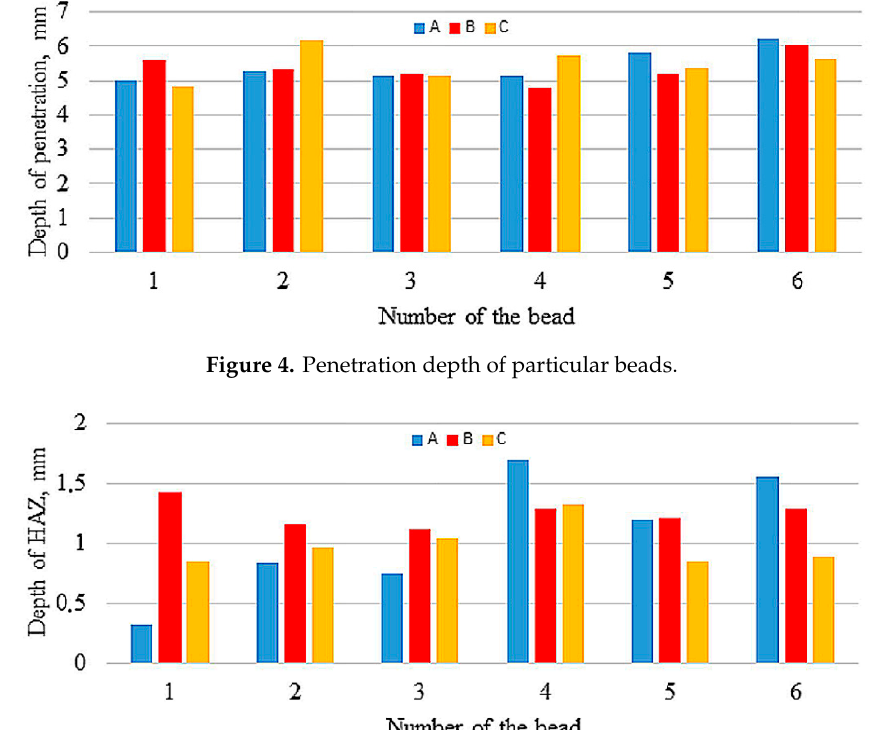
Figure 6. Height of the reinforcement in welding sequences.